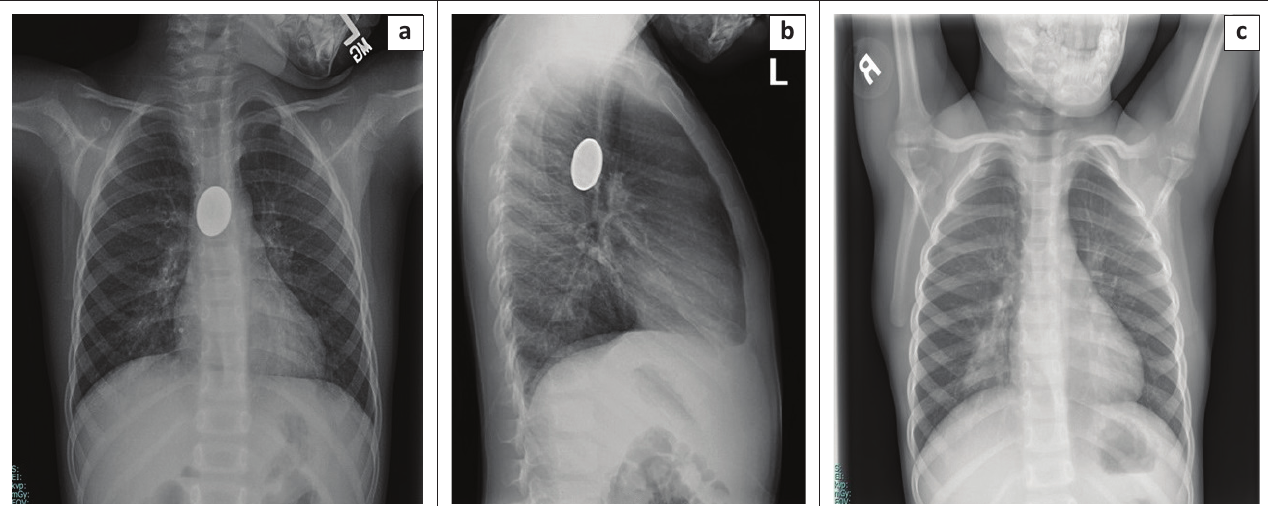
FIGURE 3: Initial frontal (a) and lateral (b) chest radiographs demonstrate a coin in the mid oesophagus of a 4-year-old male child. A follow-up radiograph (c) indicates that the coin has passed into the stomach. The child was managed conservatively.